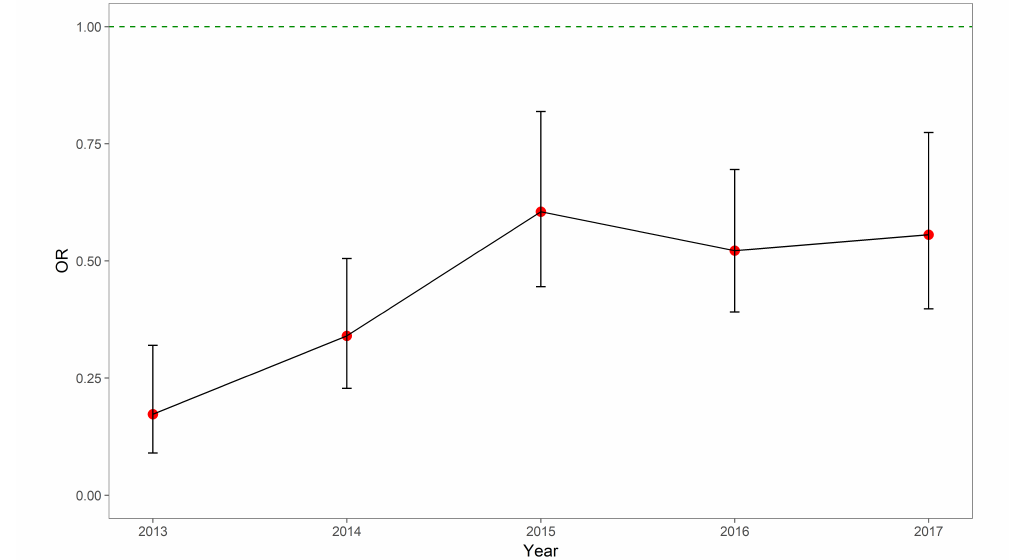
Figure 1. Odds ratios of rural patients with regard to in-hospital mortality, 2013–2017.